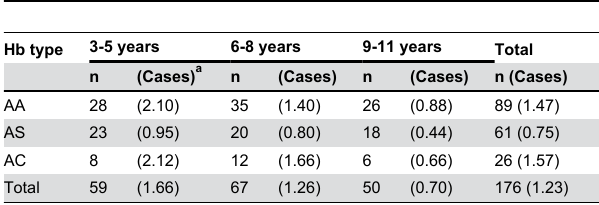
Table 1. Malaria incidence rates stratified by Hb type and age.